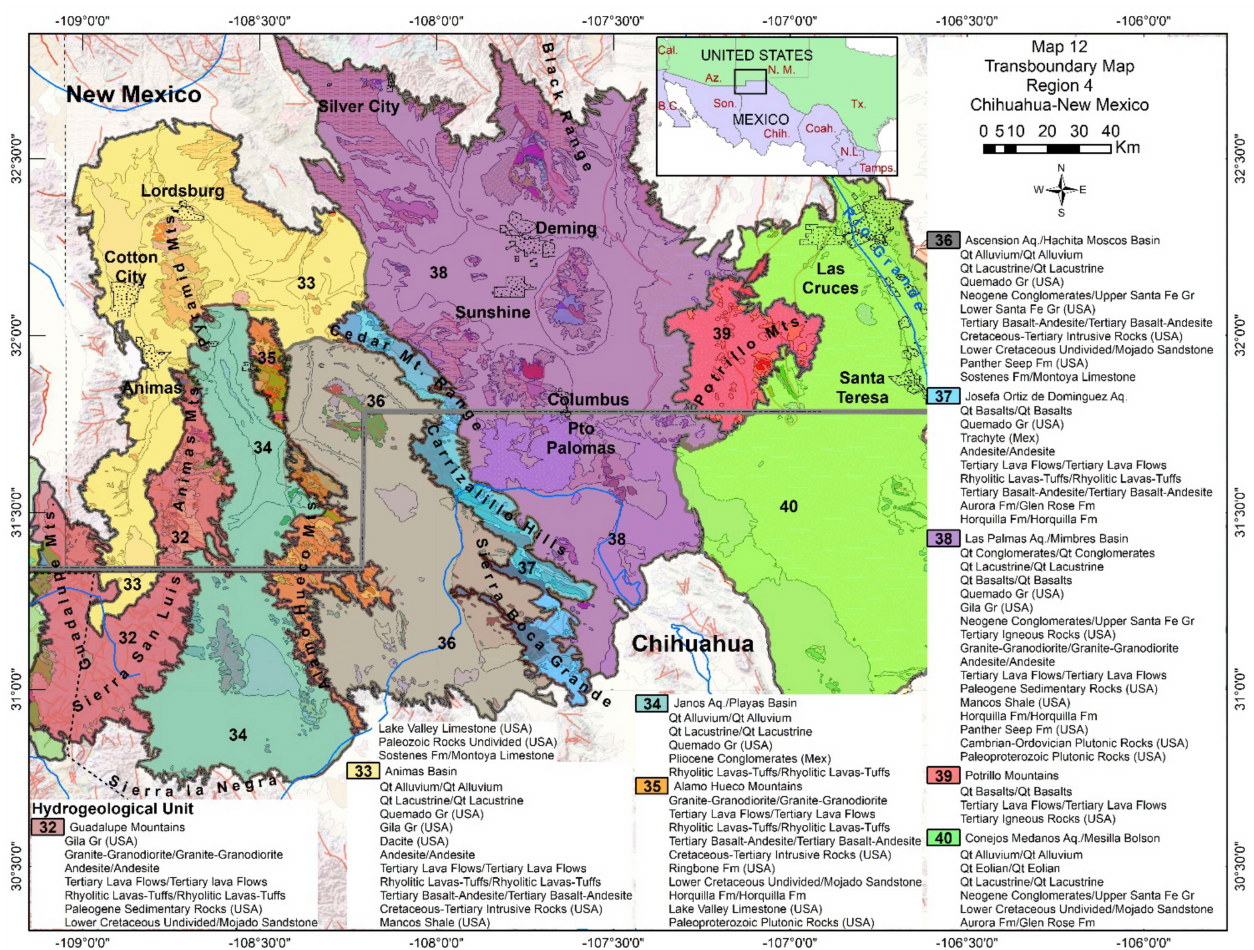
Figure 12. Transboundary map, Chihuahua—New